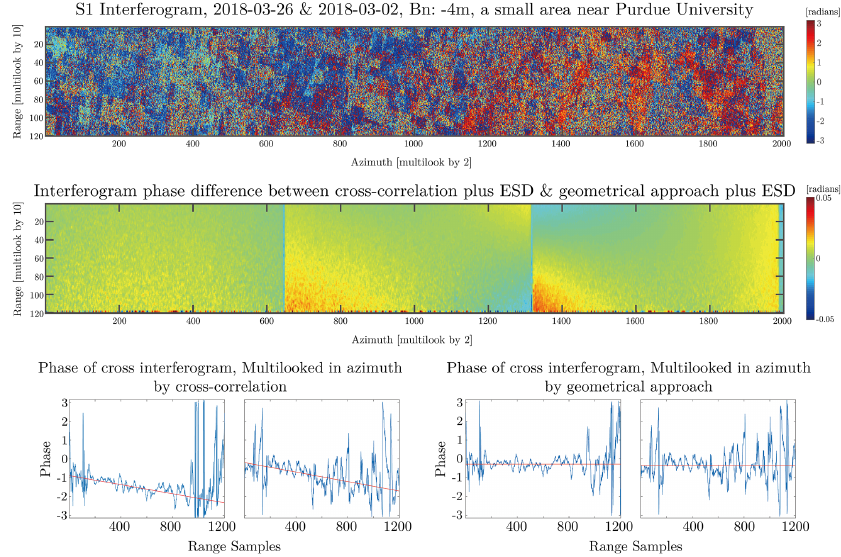
Figure 8. An example near Purdue University as a small test site. The AOI is 1200 (range) × 4000 (azimuth). ( Top ) the interferogram mutlilooked by 10 × 2 with no filter applied; ( Middle ) the difference of interferogram phase between the proposed approach and the established approach; and ( Bottom ) the cross-interferogram phases after applying the cross-correlation method and after applying the geometrical